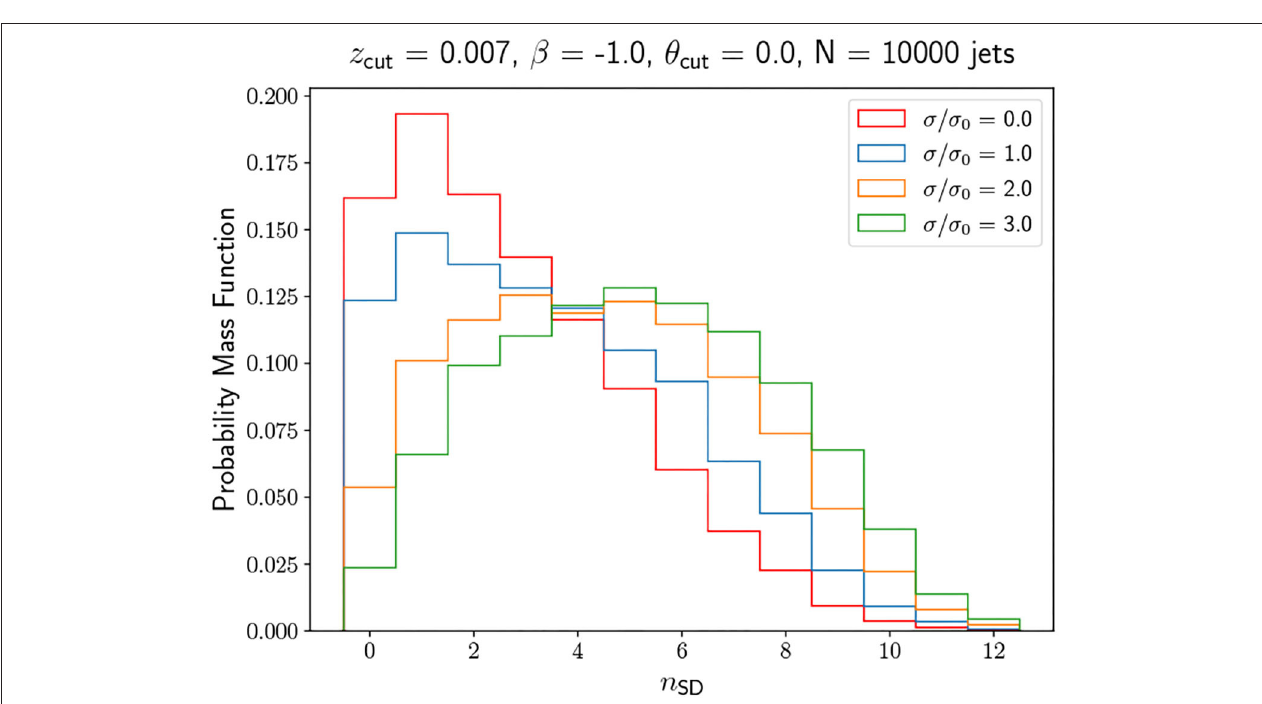
FIGURE 5 | Smeared n SD distributions obtained by applying the p T -dependent emulation of detector effects/response detailed in Equation (6) and in Buckley et al. (2020) with different scaling factors. A scaling factor of 0 indicates no smearing while a scaling factor of 1 indicates the same smearing factor as in Buckley et al. (2020).